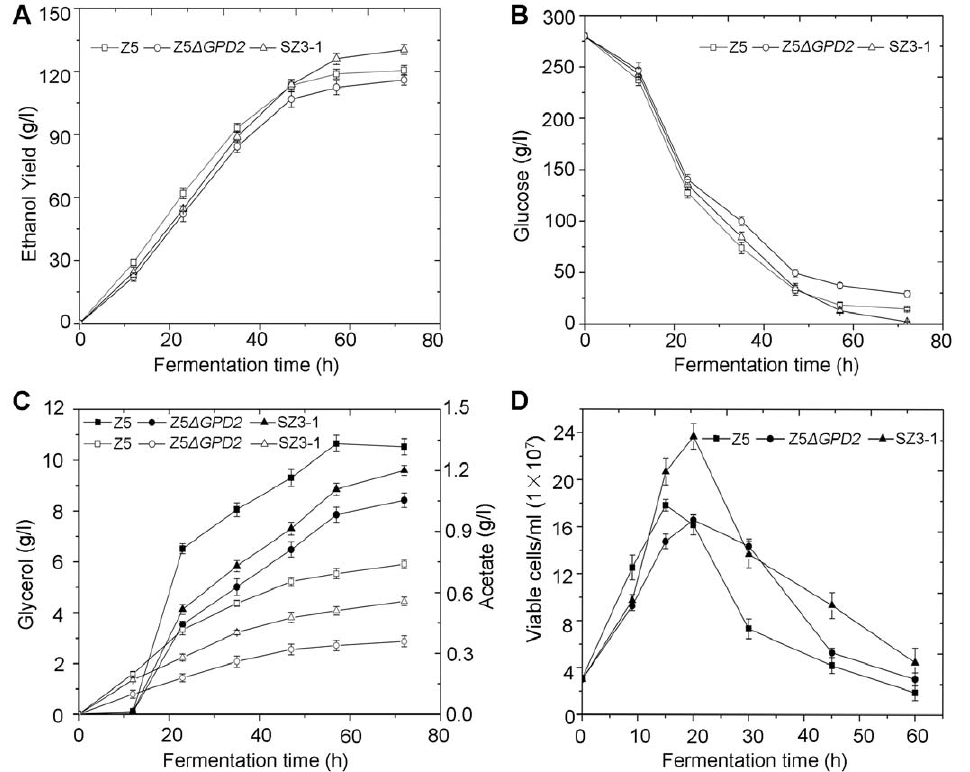
Figure 1. The fermentation performance of strains Z5, Z5 D GPD2 and SZ3-1. The ethanol yield (A), glucose consumption (B), glycerol (filled symbols) and acetate (open symbols) production (C), and cell survival rate (D) of control strains Z5 (squares), Z5 D GPD2 (circles), and shuffled strain SZ3-1 (triangles) during fermentation were monitored and compared.